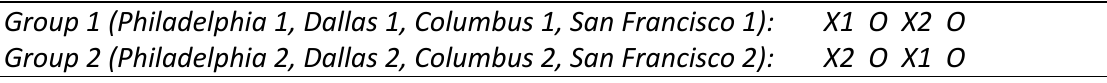
Figure 1 Experimental